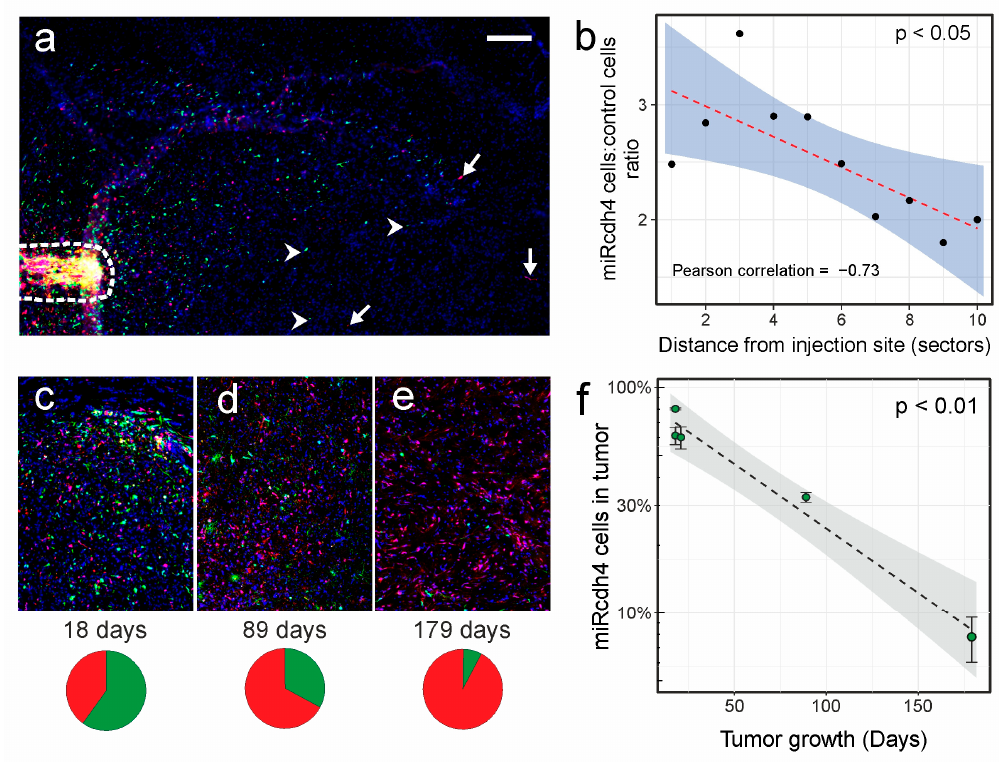
Figure 5. In vivo analysis of migration and proliferation of Cdh4 silenced GBM-07 cells. ( a ) Representative brain section near the injection site after 18 days from the transplant of Cdh4 silenced (green) or control (red) GBM-07 cells. Arrowheads point representative Cdh4 silenced cells; arrows point examples of control transduced cells; the border of the injection site is marked by a dashed